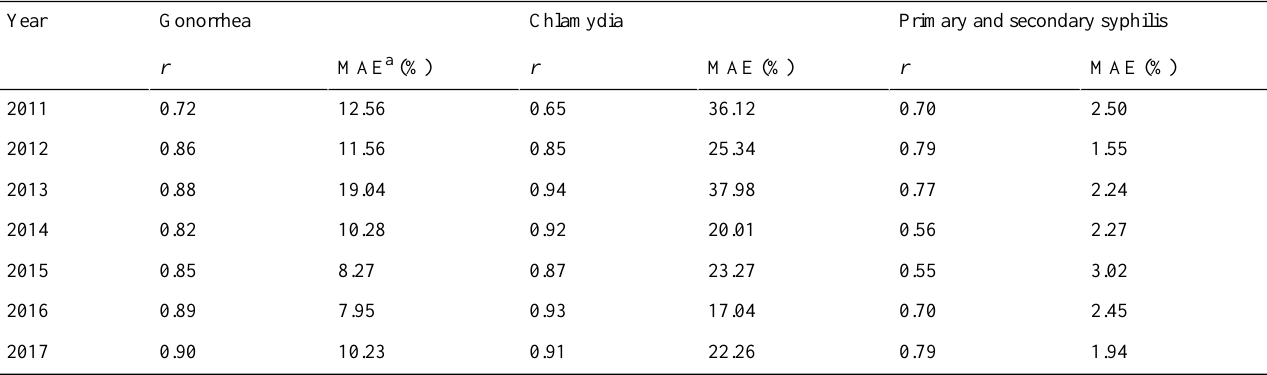
Table 2. Model prediction performance. P <.001 for all r values.